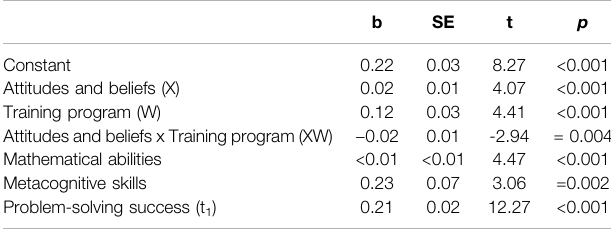
TABLE 2 | Results from the regression analysis examining the moderation of the effect of attitudes and beliefs on problem-solving success (t 2 ) by participation in the training program, controlling for mathematical abilities, metacognitive skills, and problem-solving success from the pretest. b